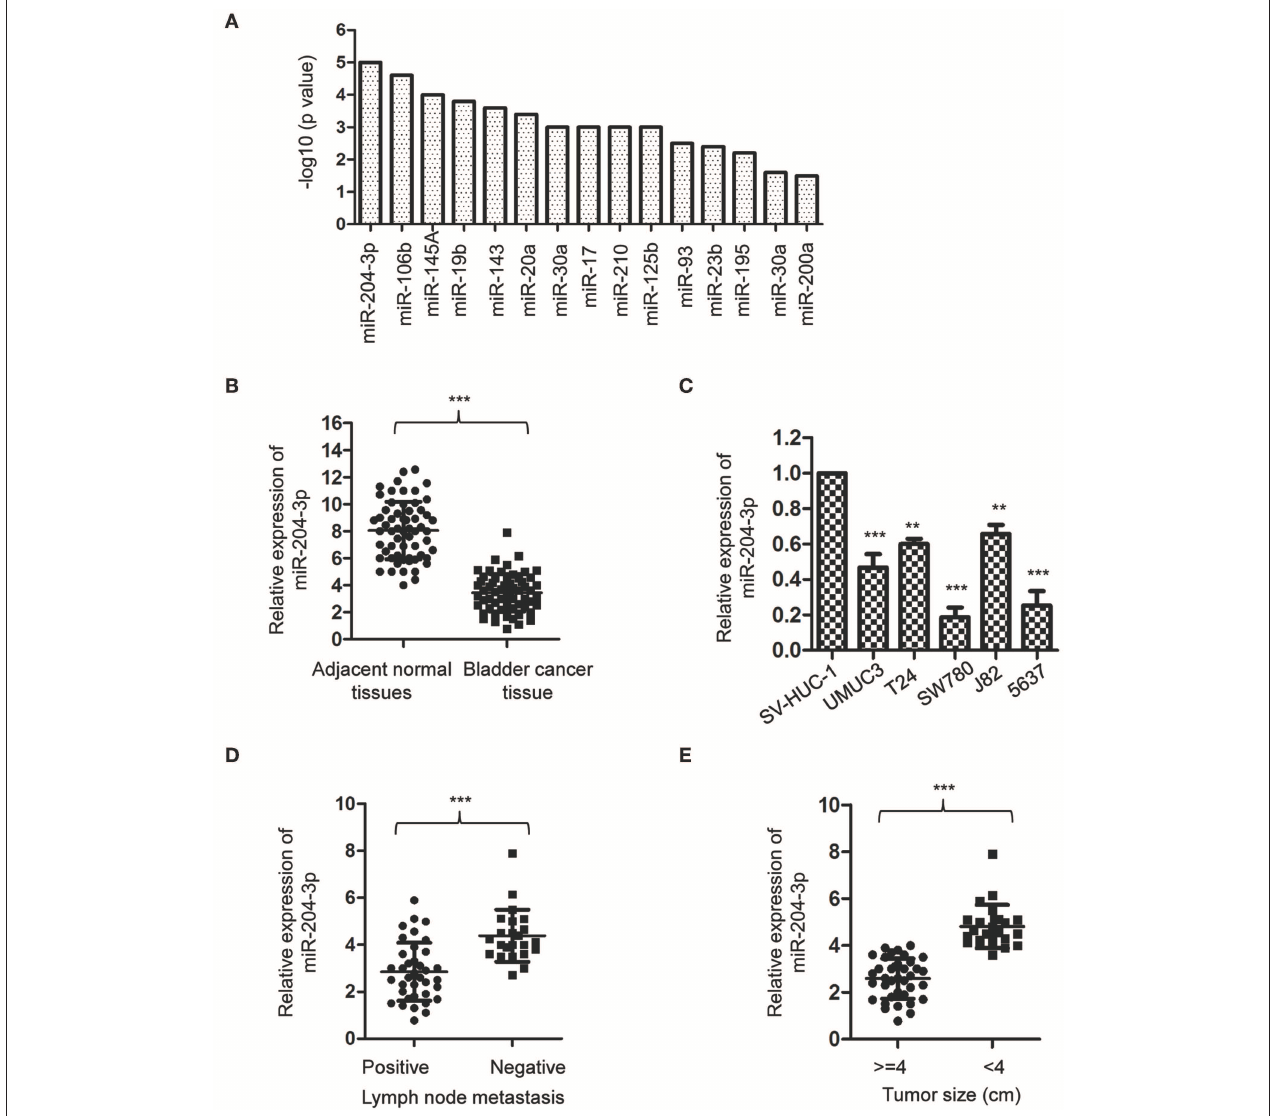
FIGURE 1 | MiR-204-3p was decreased in bladder cancer. (A) Meta-analysis on the aberrantly expressed miRNAs in bladder cancer patients. (B) The expression of miR-204-3p in 60 paired bladder cancer tissues and the corresponding adjacent normal tissues was determined by RT-qPCR. (C) The expression of miR-204-3p in bladder cancer cells and normal bladder epithelial cell SV-HUC-1 was determined by the RT-qPCR analysis. (D) The expression of miR-204-3p in the bladder cancer patients with or without lymph node metastasis was determined by RT-qPCR. (E) The expression of miR-204-3p in bladder cancer tissues stratified by tumor size was determined by RT-qPCR. ** P < 0.01 and *** P < 0.001. RT-qPCR, reverse transcriptase quantitative